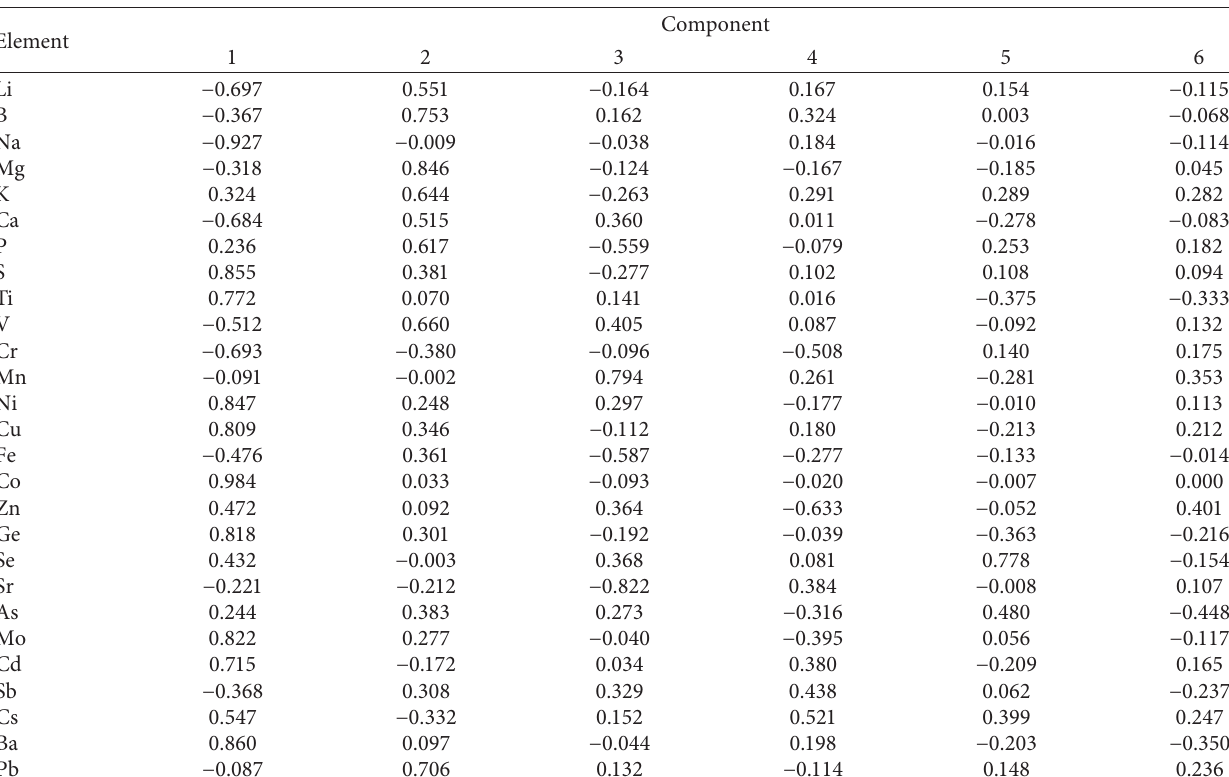
Table 9: Contribution value of the element’s principal